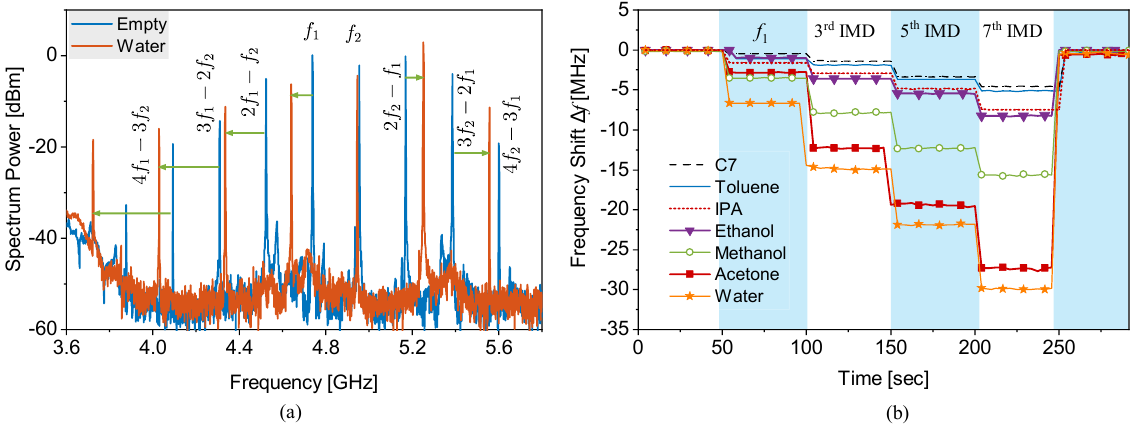
Figure 39. Intermodulation-based sensor response. ( a ) IMPs in the spectrum analyzer for f 2 = 5 GHz and f 1 = 4.75 GHz. ( b ) Material characterization and sensitivity comparison using 3rd, 5th, and 7th IMPs. Reprinted with permission from Ref.